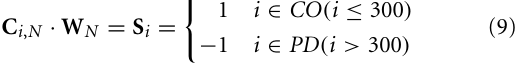
FIGURE 7 | Combination of models . (A) Line of plot of A (cid:48) with respect to SNR.Training data set performance is in blue, new data is in green, and new subject data is in red. Each model-delay pair number: 1, 5, 10, 15, 20, 25, 30 is plotted with a separate line with each data set having seven lines.The black